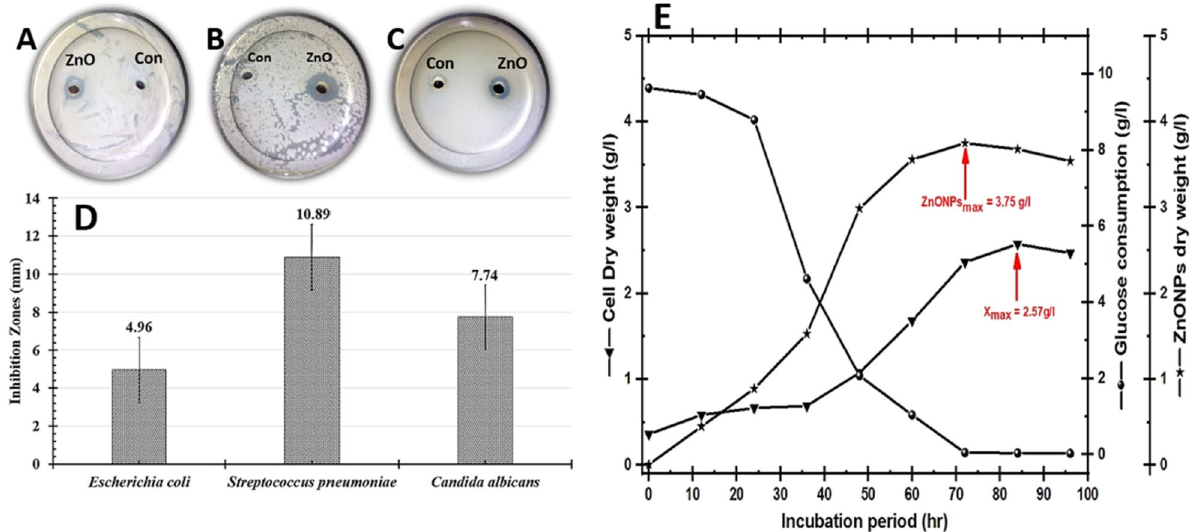
Figure 1. Represents the behavior of the biosynthetic ZnO NPs using mixed cell-free extract of strain E56 as a reductant/capping, and Zn